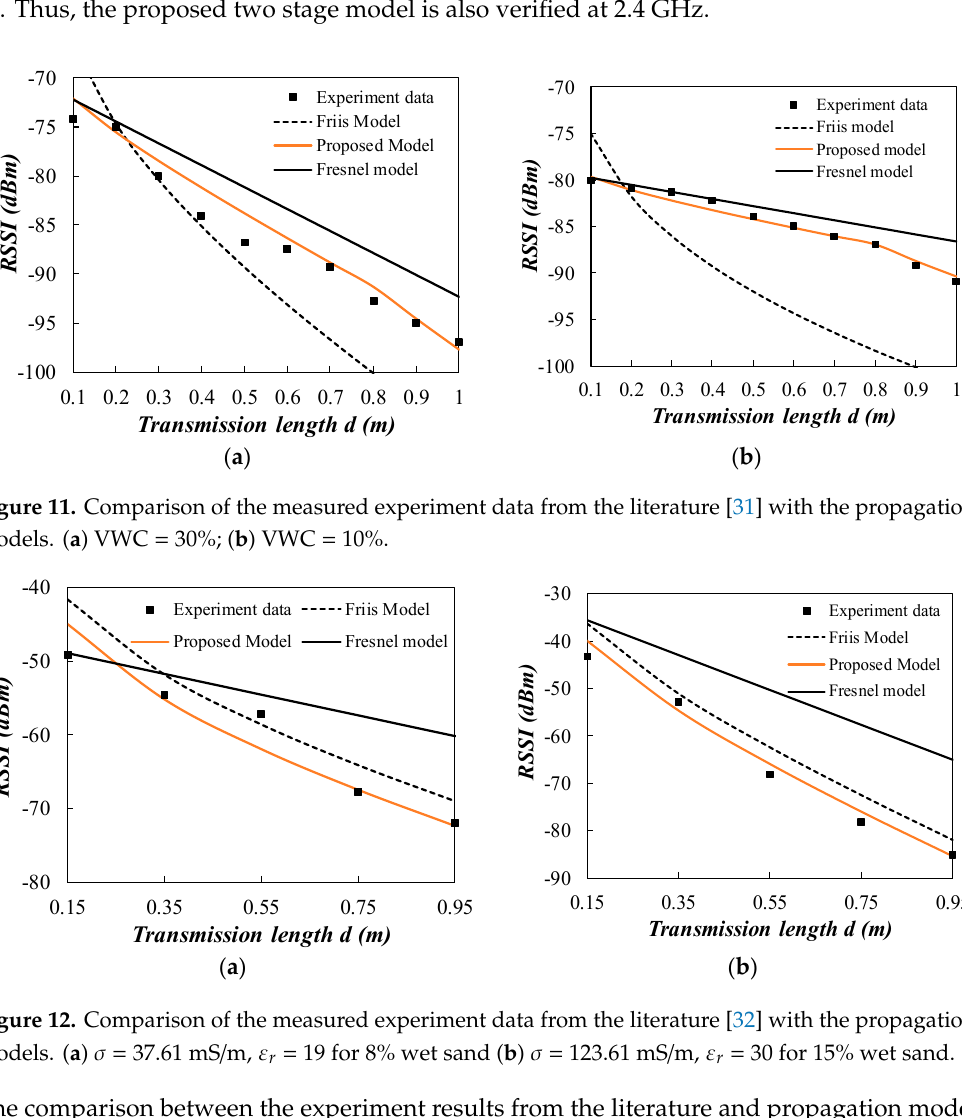
Figure 11. Comparison of the measured experiment data from the literature [31] with the propagation models. ( a ) VWC = 30%; ( b ) VWC = 10%.